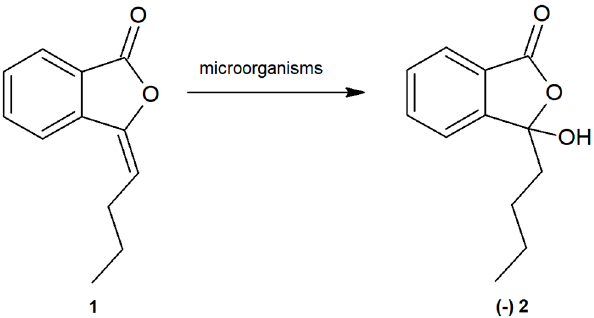
Figure 1. Biotransformation of 3- n -butylidenephthalide ( 1 ) to (-)-3-butyl-3-hydroxyphthalide ( 2 ) using whole fungal cells.